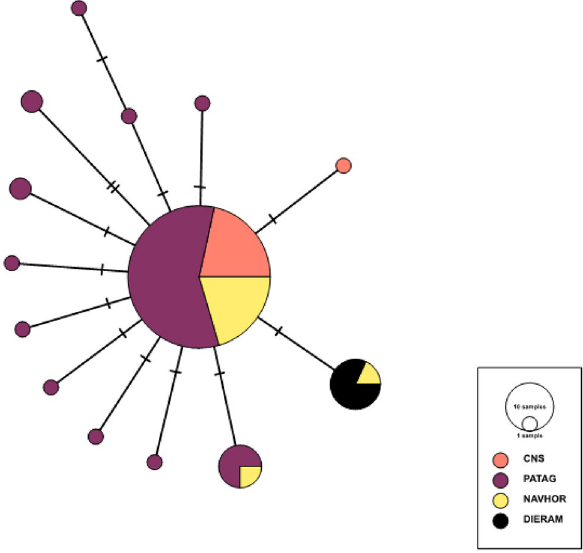
Figure 5. Mitochondrial haplotype network of Aphrastura geographic groups. Each circle in the network corresponds to a different haplotype, the size of the circles corresponds to haplotype frequencies, and the colors correspond to the different geographical groups. CNS Central, north and south, PATAG Patagonia (Chiloé to Tierra del Fuego), NAVHOR Navarino and Horn islands, DIERAM Diego Ramírez (representing the proposed new species A. subantarctica